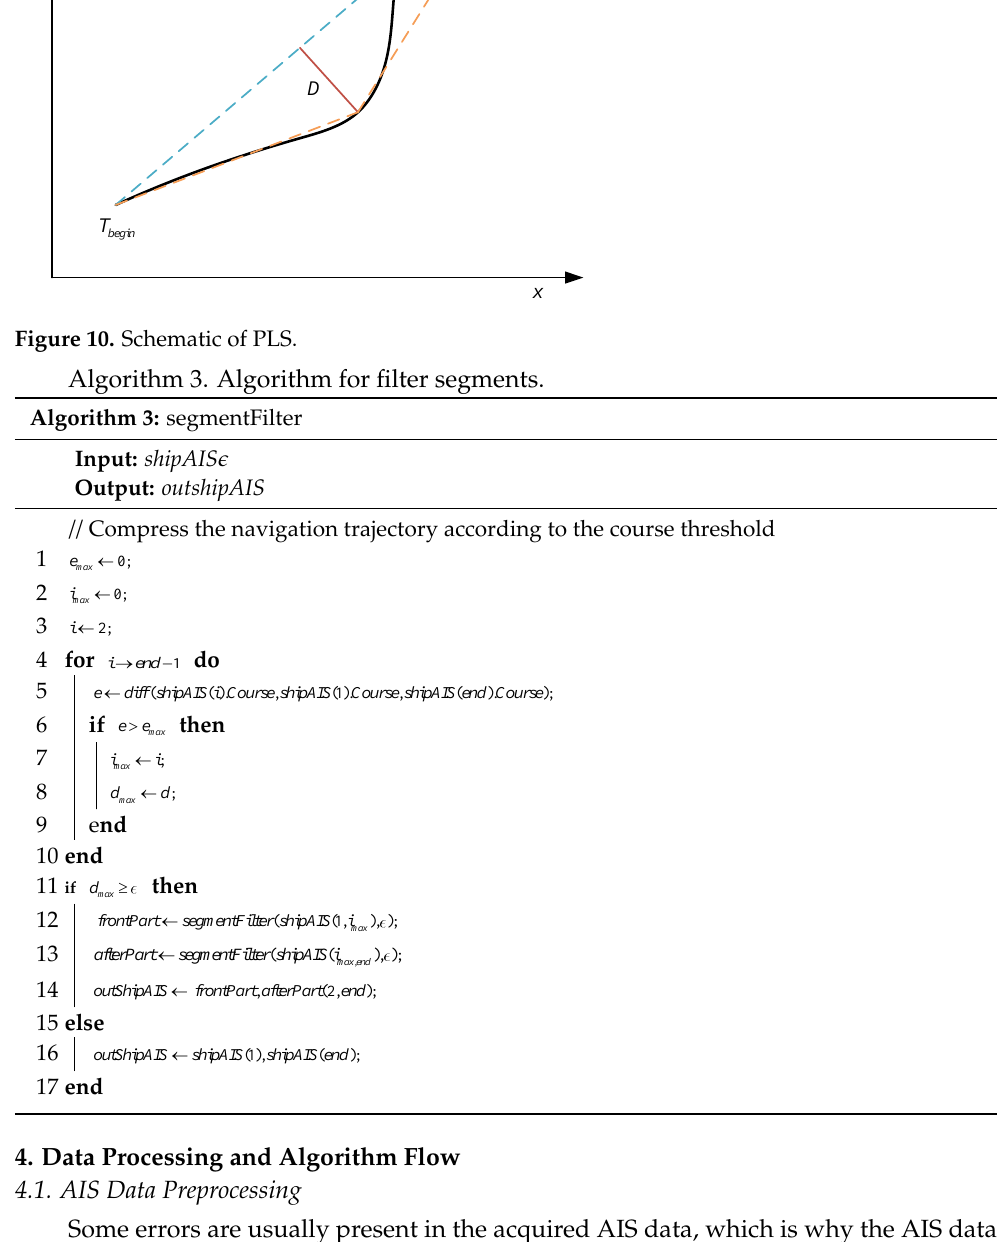
Figure 10. Schematic of PLS. begin